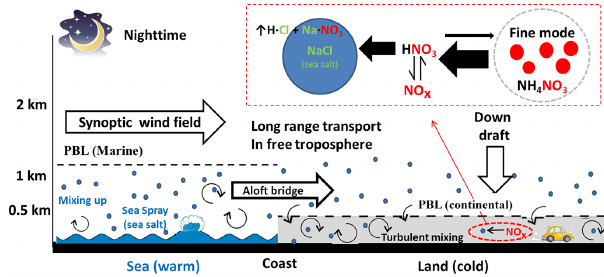
Figure 11. Schematic of sea salt transportation and its influence on nitrate particle